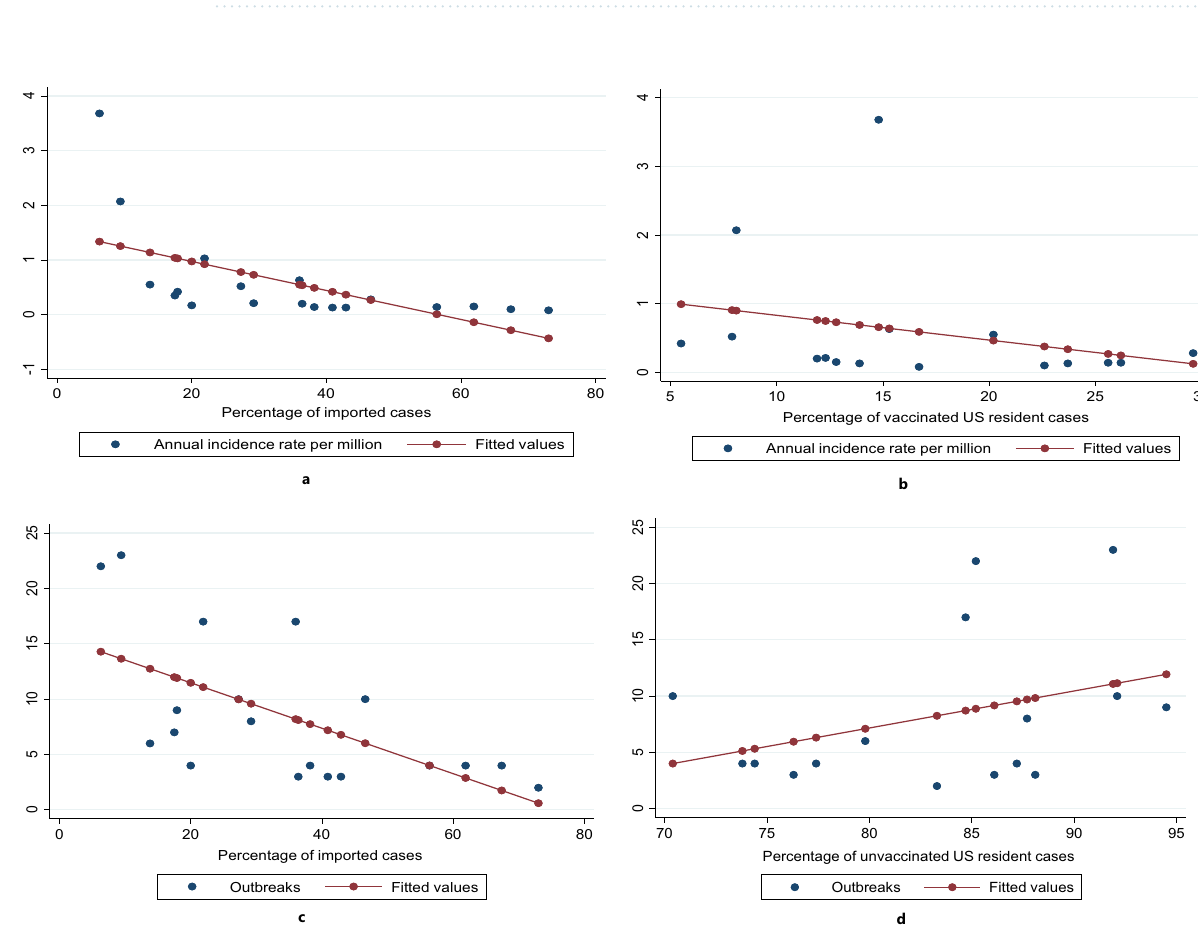
Figure 3. ( a ) Linear regression model of the association between the annual incidence rate and the percentage of imported cases. ( b ) Linear regression model of the association between the annual incidence rate and the percentage of vaccinated cases. ( c ) Linear regression model of the association between the number of outbreaks and the percentage of imported cases. ( d ) Linear regression model of the association between the number of outbreaks and the percentage of unvaccinated